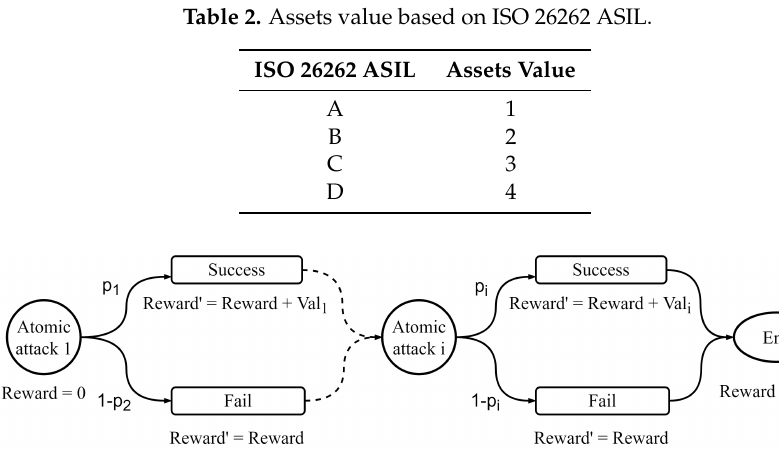
Figure 3. Attacker